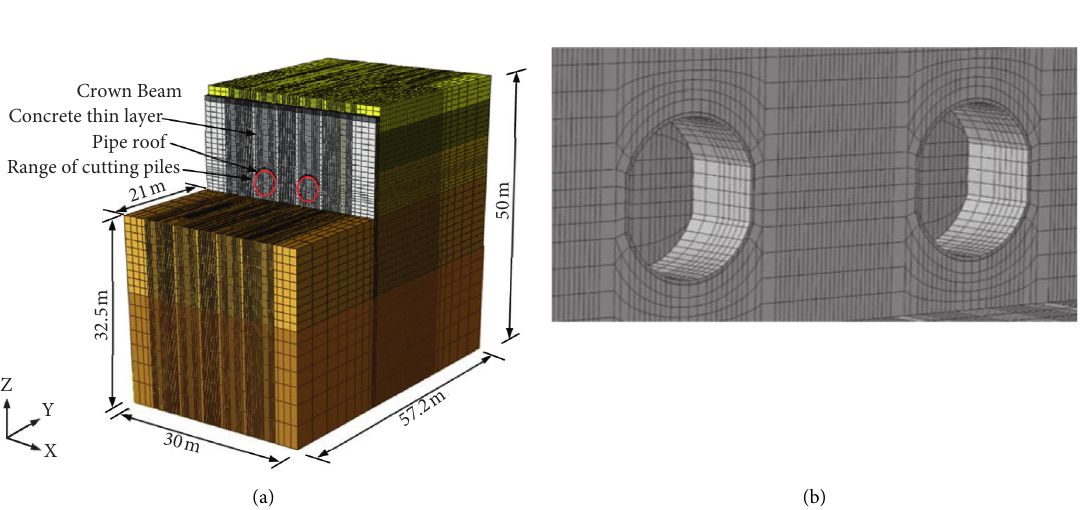
Figure 3: Perspective view of the developed numerical model. Perspective view (a). Enlarged view